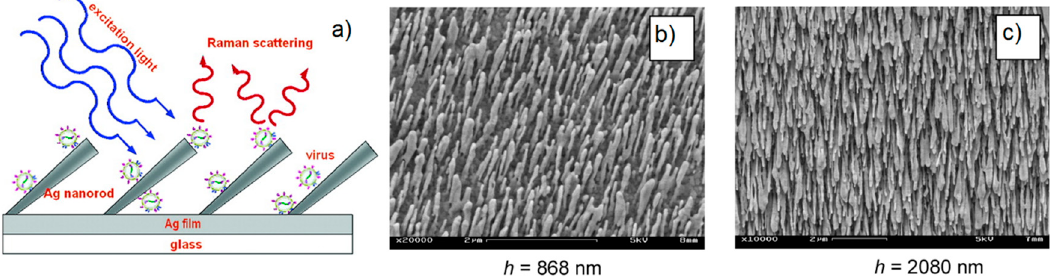
Figure 54. Scheme of silver nanorod array substrates fabricated using electron beam/sputtering evaporation (E-beam) system, in oblique angle deposition (86°), on a 500 nm Ag thin film base layer ( a ), and SEM images of two samples with different nanorod length h = 868 nm (with a diameter of 99 nm) ( b ), and h = 2080 nm ( c ). Reproduced with permission from Shanmukh et al. [467]. Copyright (2006), the American Chemical Society.